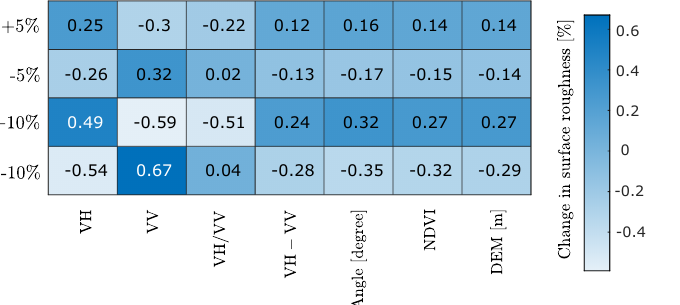
Figure 13. Heat map illustrates the the sensitivity of the PCA-MM-SVR model for +5%, − 5%, +10%, and − 10% uncertainty in the input